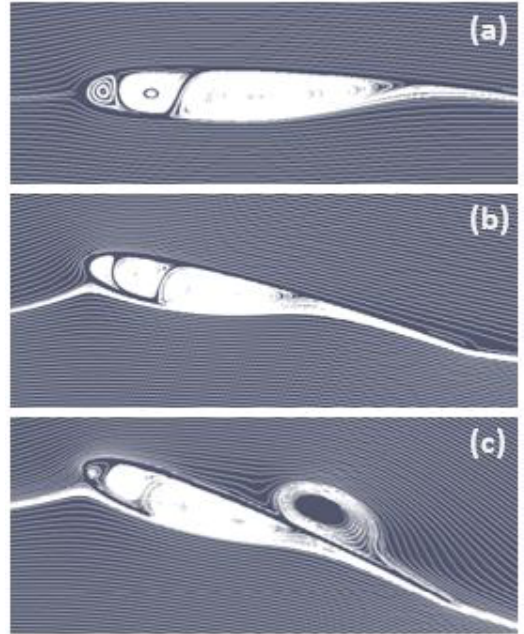
Figure 4. Streamline plots of the flow around the J-blade at angle of attack of ( a ) 0 degrees, ( b ) 10 degrees, and ( c ) 20 degrees.